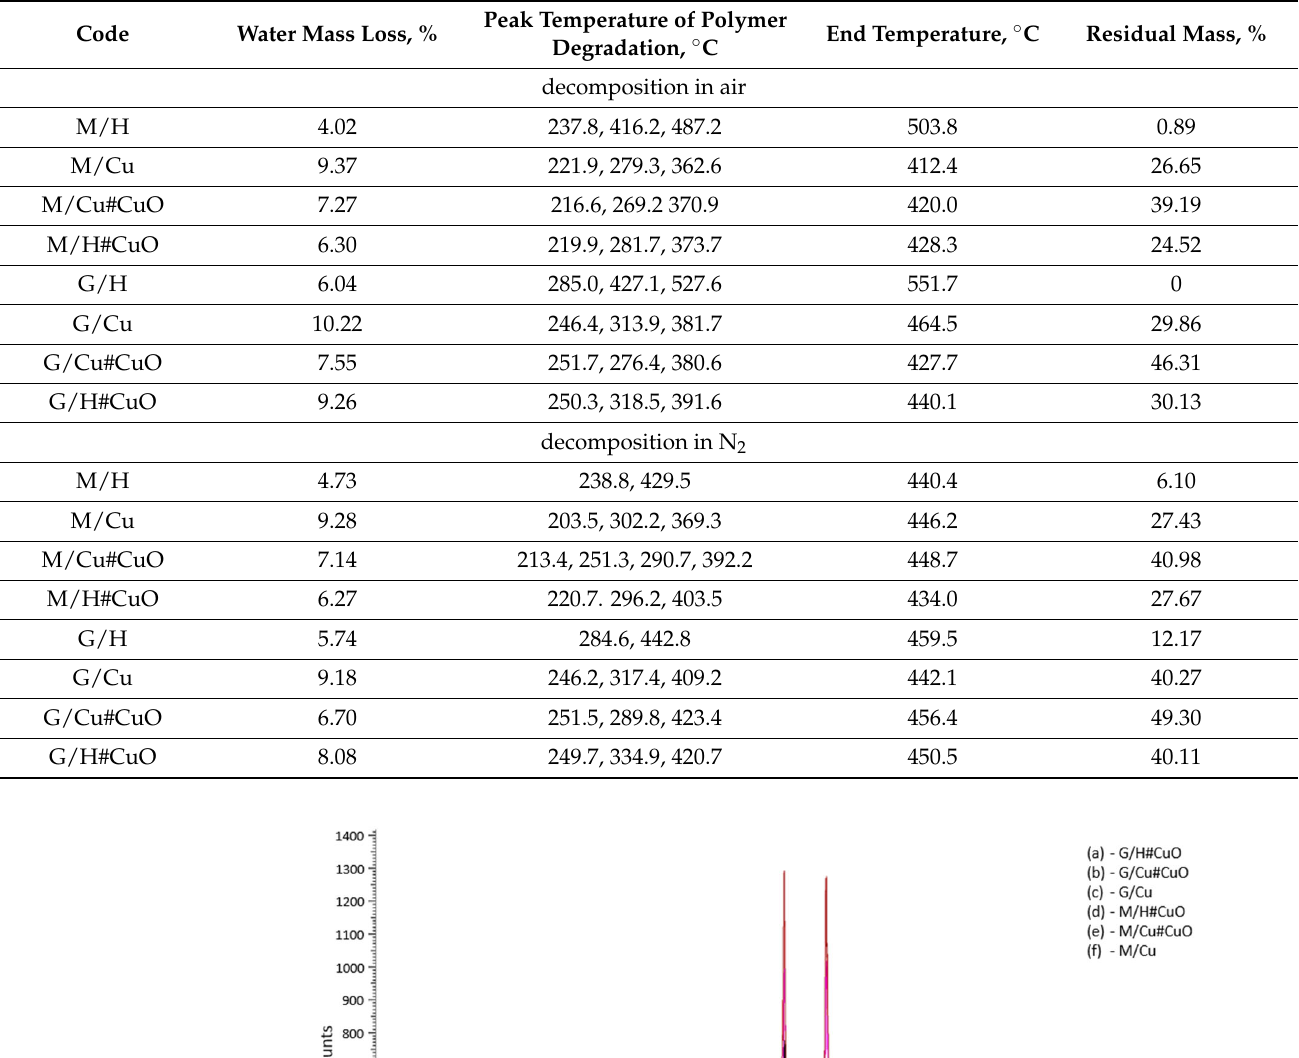
Table 3. Thermal decomposition results.